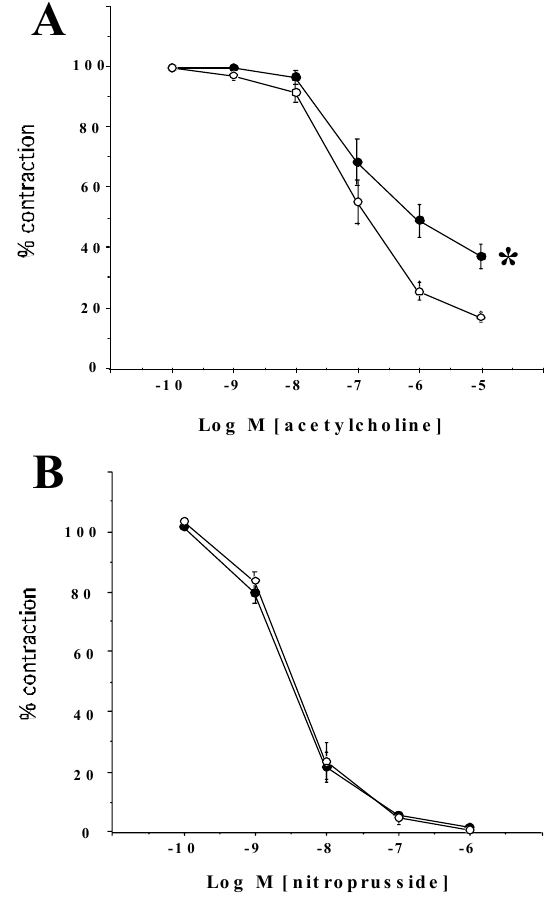
Figure 2. (A) ApoE-KO aortic rings exhibited im- paired endothelium-dependent relaxation in response to acetylcholine compared with ApoE-KO/BH4 mice (n = 5 to 6 animals per group; *P = 0.03). (B) Endothelium-independent vessel relaxation in response to the NO donor sodium nitroprusside was identical in both groups of